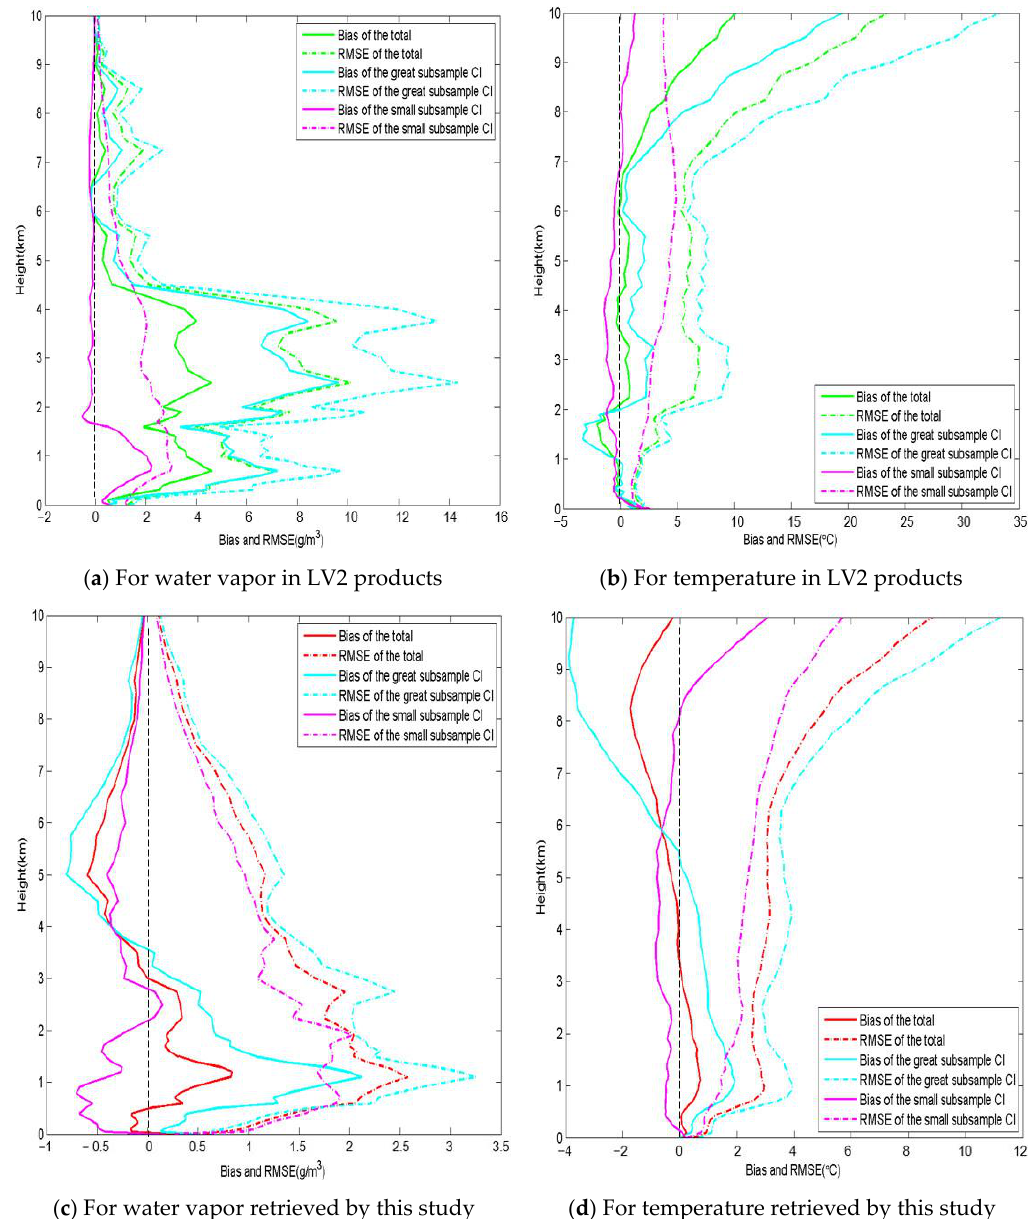
Figure 5. The performance of the retrieved atmospheric temperature and humidity profiles for the two kinds of cloud types in terms of Cloud Impact index. ( a , b ) BIAS and RMS of the vendor-provided LV2 products, ( c , d ) BIAS and RMS of the retrievals from 𝑇 𝐵𝑂2 by this study.